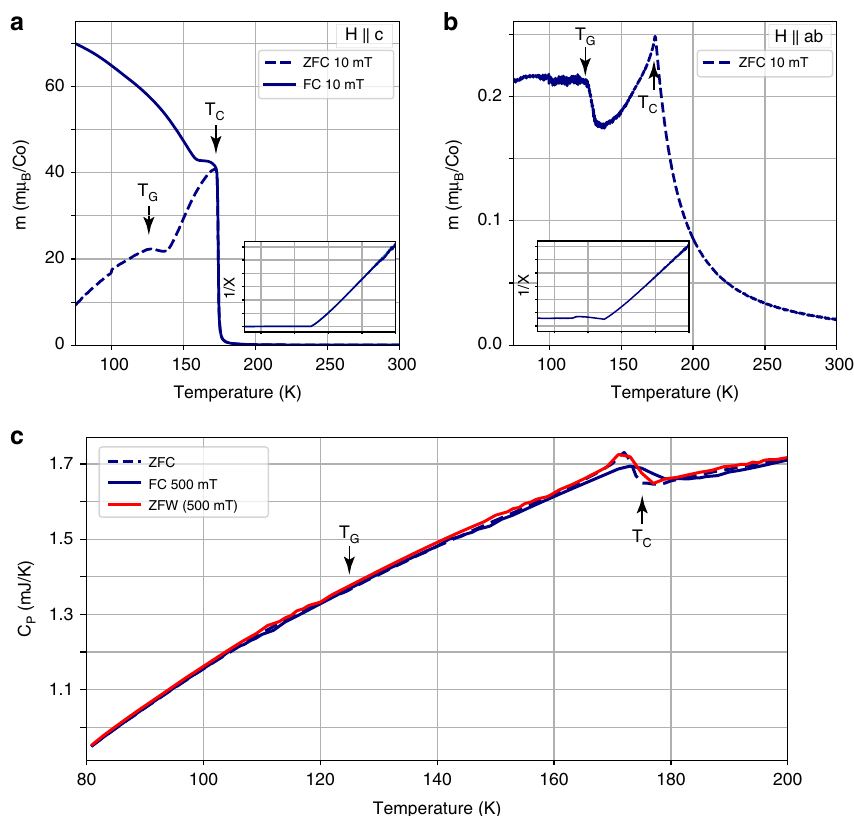
Fig. 5 Magnetic and thermodynamic properties of the transition at T G . a , b In-plane and out-of-plane magnetization measurements on a single crystal. a Out-of-plane (H jj c) magnetization as a function of temperature while warming up the sample after ZFC (dashed) and fi eld cooling (solid) and measuring under a fi eld of 10 mT. The curves are characteristic of a FM with a Curie temperature of 175 K, with a small feature at 125 K (marked with a small arrow on the ZFC curve). b In-plane (H jj ab) magnetization as a function of temperature while warming up the sample after ZFC under a fi eld of 10 mT. The curve is characteristic of an AFM with a Néel temperature of 175 K, with a feature at 125 K. Additional magnetization data can be found in Supplementary Note 3. c Single crystal heat capacity as a function of temperature for 80 (cid:3) 200 K. These measurements reveal no feature at 125